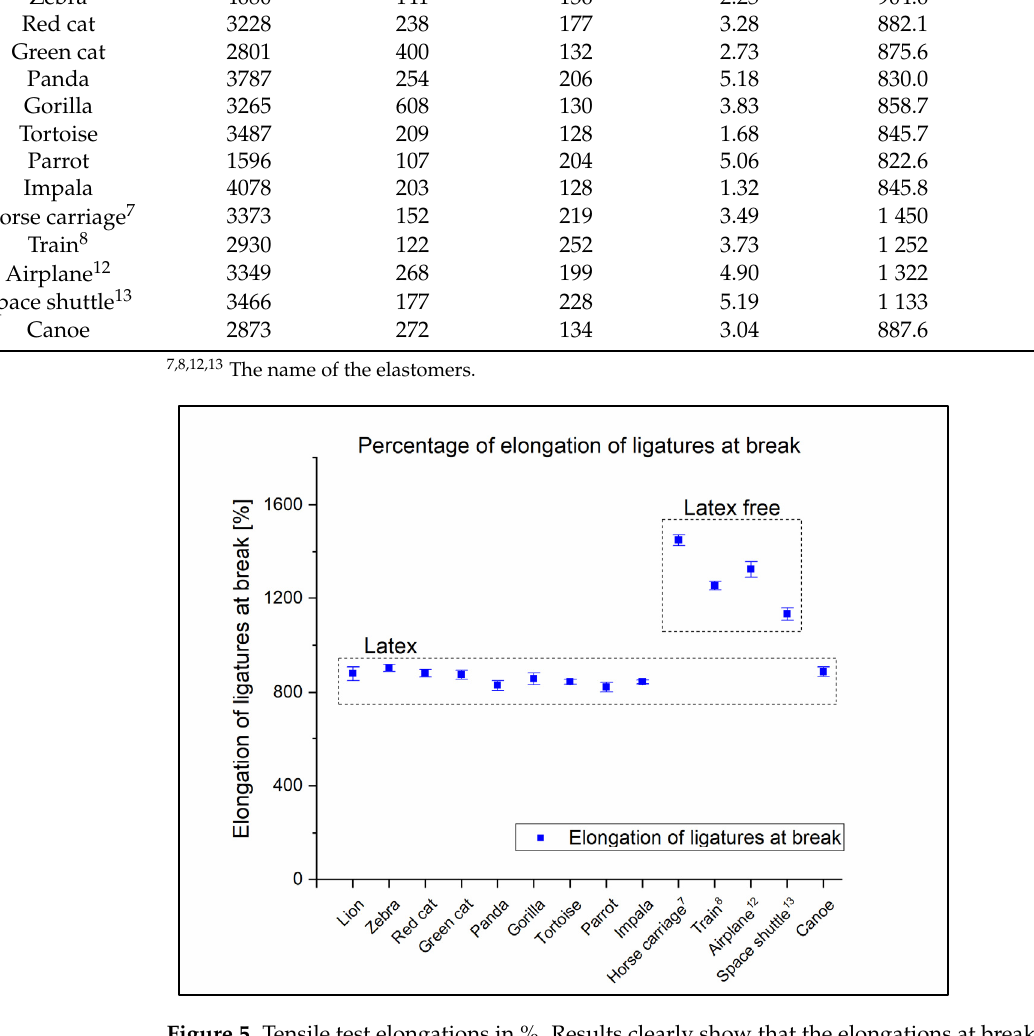
Figure 5. Tensile test elongations in %. Results clearly show that the elongations at break of the latex ligatures are approximately equal regardless of manufacturer.